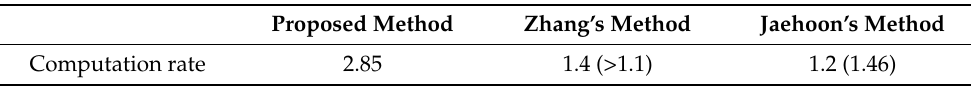
Table 9. The efficiency comparison among the existing approaches. (Unit: million